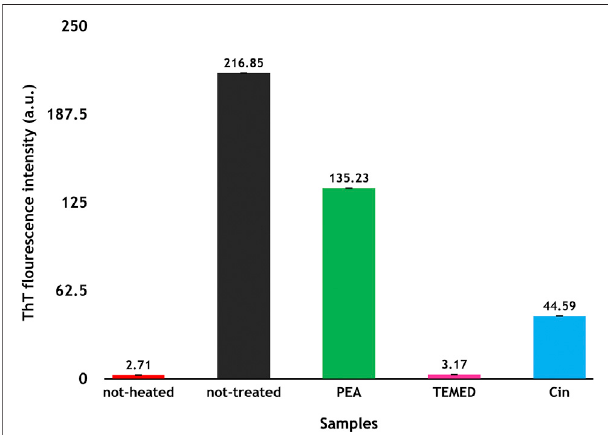
FIGURE 9 | ThT analyses of α -synuclein fi brillation in the presence and absence of the volatile compounds Cin, PEA, and TEMED after 3 days of incubation. The results are based on an average of two to three repetitions, and the difference in the intensities of the emissions is compared to that of the two controls including the not-heated and not-treated samples. ThT emission was measured at 484 nm.